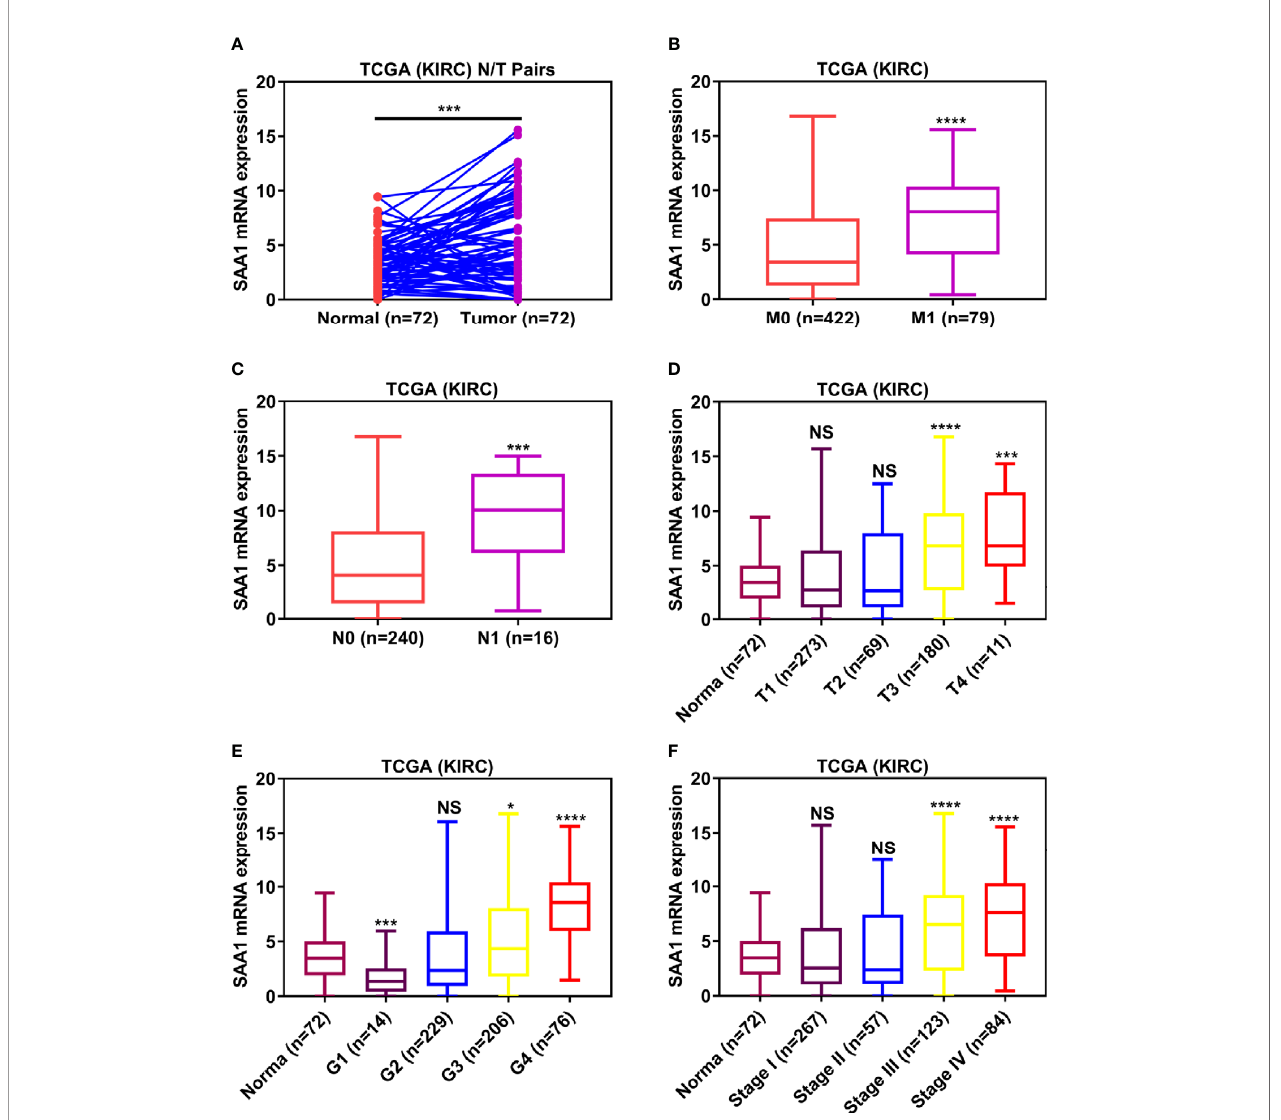
FIGURE 2 | Analysis of SAA1 mRNA expression using TCGA database. (A) The mRNA expression levels of SAA1 were up-regulated in ccRCC samples, which were downloaded from TCGA-KIRC database containing 72 paired ccRCC samples. The expression levels of SAA1 mRNA were compared in various tumor